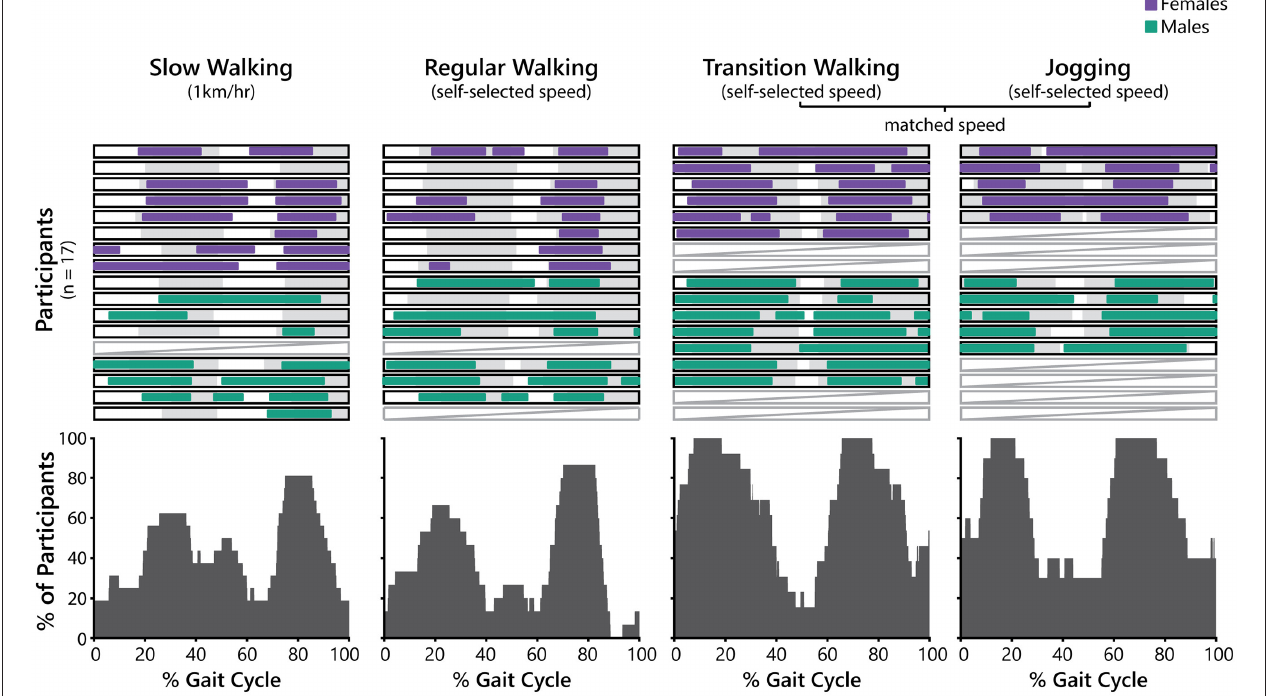
FIGURE 3 | Periods of bursting pelvic floor muscle (PFM) activity during slow walking, regular walking, transition walking, and jogging normalized to gait cycle (0% represents right heel strike). Upper panels: Periods of PFM bursting activity are presented for each participant in each condition. PFM bursting periods are represented by the purple (female participants) and green (male participants) horizontal bars. The gray bars indicate phases in the gait cycle where the participant was in single-leg support. Pale gray boxes with a diagonal line indicates that the data for this participant at this condition was discarded. Lower panels: Summed periods of PFM bursting activity in each condition. Each plot presents the percentage of participants that exhibited PFM bursting for each frame of the gait